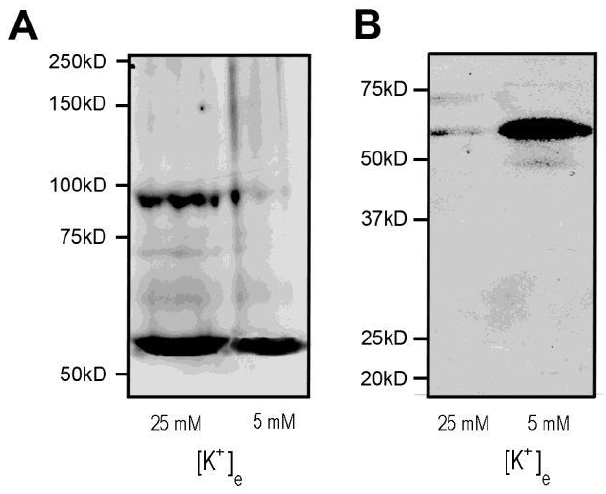
FIGURE 1. Localization of BECN 1 in BCL-2 immunoprecipitates (A) or whole protein extracts (B) from postnatal mouse cerebellar organotypic cultures. (A) BECN 1 coimmunoprecipitates with BCL-2 approximately the 85-kD band. The band at approximately 65 kD corresponds to immunoprecipitated IgGs recognized by the secondary antibody. (B) Expression of BECN 1 is drastically reduced under elevated [K + ] e in comparison to physiological [K + ] e